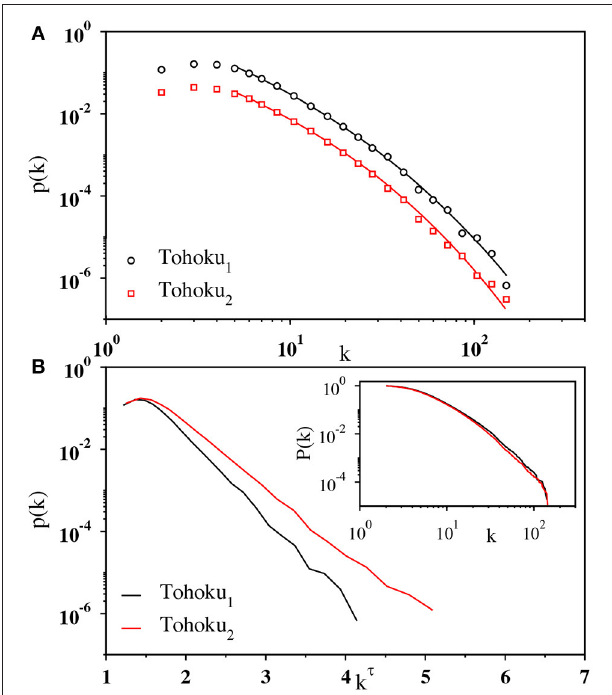
FIGURE 3 | (A) Log-log plot of the binned data (open circles) for degree distribution p ( k ) of the whole magnitude time series Tohoku 1 (black) and Tohoku 2 (red). The solid lines are the fit of the corresponding data using Equation (4) whose parameters are A = 195.0 and 57.68, 1 / k 0 = 210.0 and 51.03, and τ = 0.284. and 0.325, respectively. The data for Tohoku 2 has been shifted vertically for visual clarity. (B) Plot of the same data against k τ , with k being the degree of the nodes, on a semilog scale exhibits a straight line in the intermediate regime. Inset: log-log plot of the cumulative degree distribution P ( k ) for the corresponding data sets.